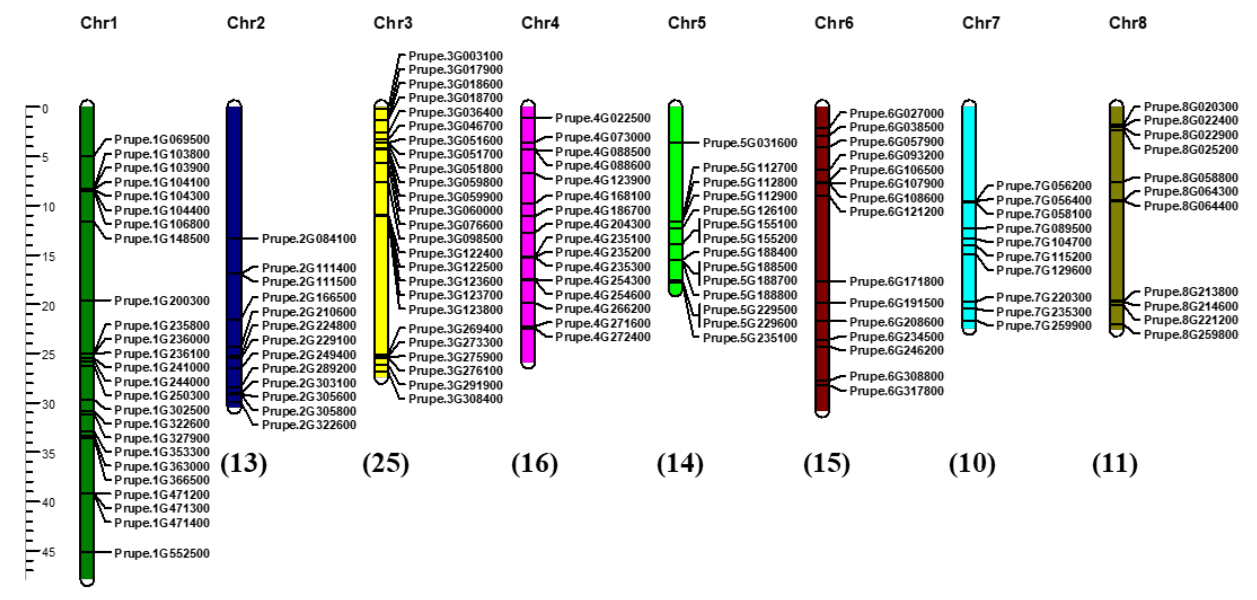
Figure 2. Chromosomal distribution of PpABC genes. The chromosomes were visualized using MapChart program. The chromosome number is indicated at the top of each chromosome, and the number of PpABC genes in each chromosome is indicated at the bottom of each chromosome in brackets. The scale bar described the relative lengths of the chromosomes in megabases (Mb).